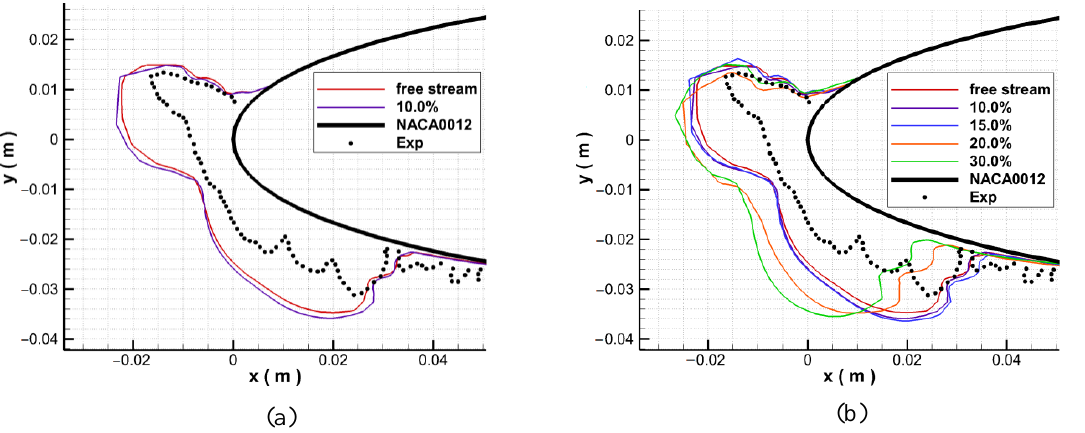
Figure 6. Ice shapes at different blockages. ( a ) Ice shape with 10% blockage. ( b ) Ice shape of NACA0012 airfoil at different blockages.